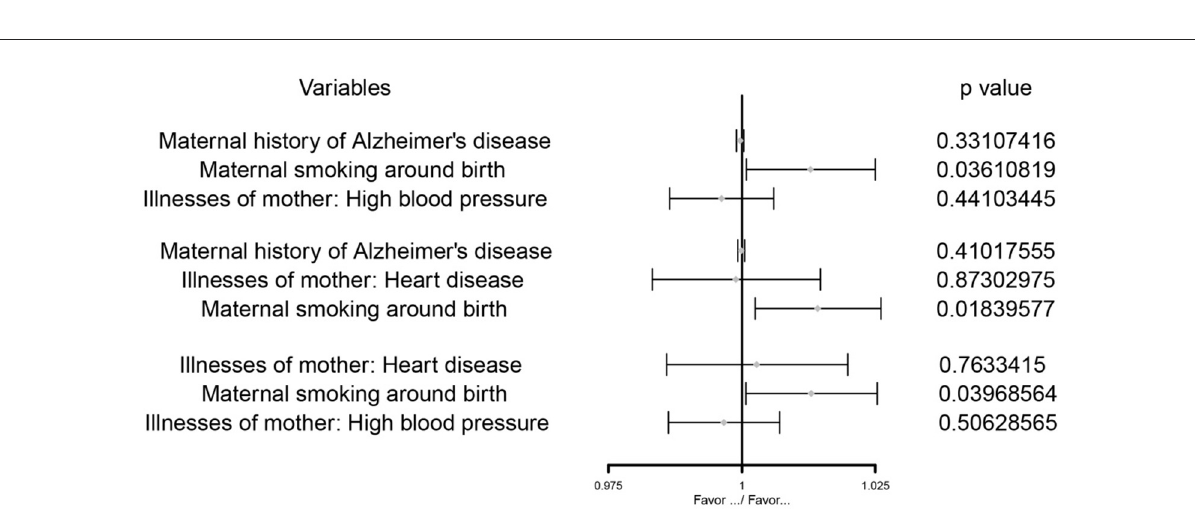
FIGURE3 The MVMR forest plot of maternal smoking around birth on childhood asthma controlling the maternal history of Alzheimer’s disease and illnesses of the mother: high blood pressure, the maternal history of Alzheimer’s disease and illnesses of the mother: heart disease, illnesses of the mother: high blood pressure and illnesses of the mother: heart disease